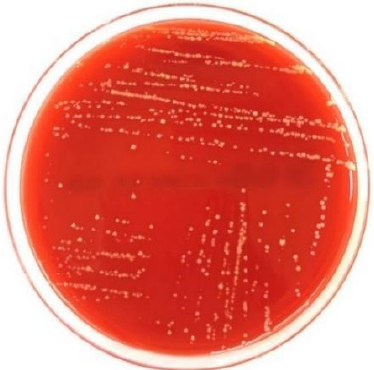
Figure 2. Hemolysis test carried out on S. yanoikuyae SJTF8 showed no hemolysis by